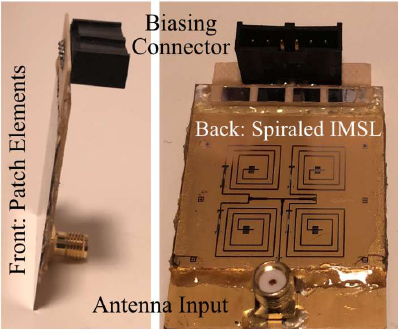
Figure 31. First realized two-dimensional electronic steerable antenna array using a spiraled IMSL phase shifter with 100 µ m LC layer height, being processed similar to LCD technology [170,175]. Side view of the array with an overall thickness of 1.5 mm only ( left ). Bottom view with the four spiraled IMSL lines, the feeding network, and four thin bias lines (not visible) on the substrate as well as an SMA connector for the RF signal and a four-pin DC connector to control the four delay line phase shifters ( right ). Courtesy of ALCAN Systems